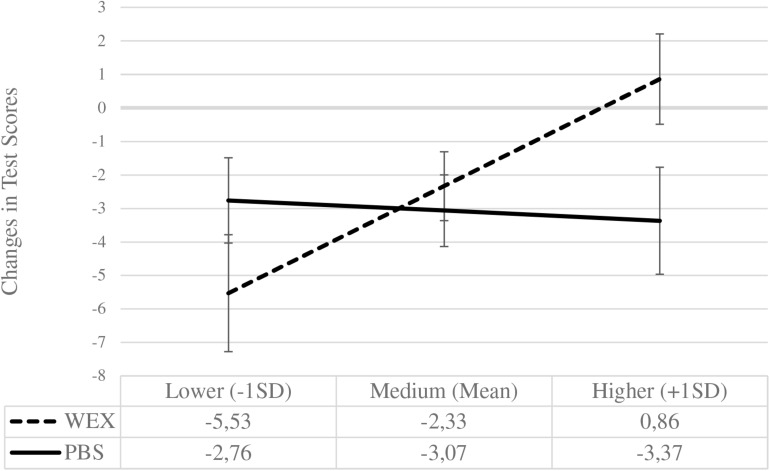
Performance changes across both post-test by learning condition and initial performance expectancies. Change scores on the y-axis were computed by subtracting the delayed post-test scores from the immediate post-test scores: Zero means no change, negative values mean performance loss, and positive values mean performance gains. The x-axis anchors these changes for both learning conditions (WEX, worked-example (0), n = 32; PBS, problem-solving (1), n = 29) for lower, medium, and higher levels of performance expectancies. Error bars represent the standard error of the mean [WEX: 1.74 (–1SD), 1.03 (Mean), 1.35 (+1SD); PBS: 1.27 (–1SD), 1.07 (Mean), 1.60 (+1SD)].